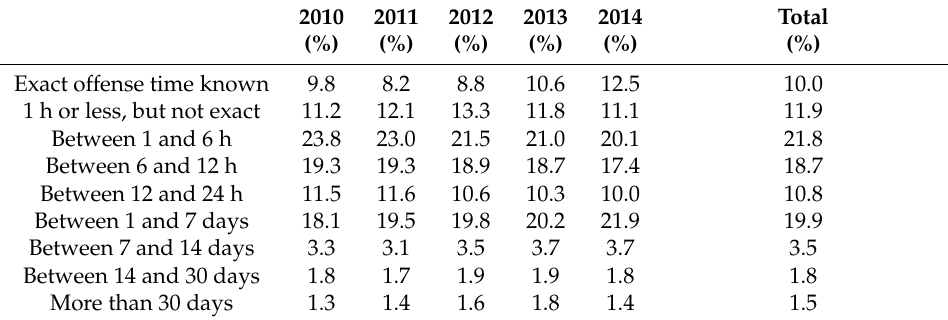
Table 3. Distribution of uncertainty in the temporal data available for Swedish burglaries over five years. The temporal uncertainty is calculated as the difference between of fense start and of fense end